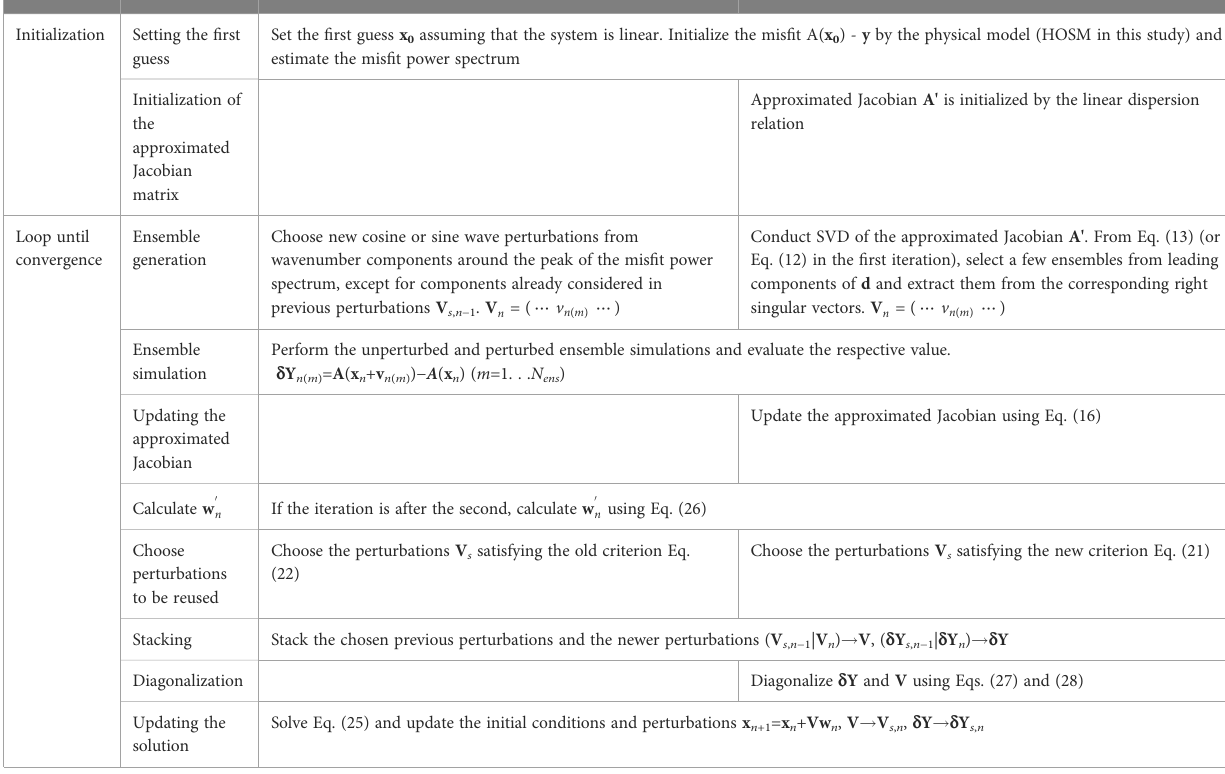
TABLE 1 Scheme of SWEAD and SWEAD-S. Procedure SWEAD